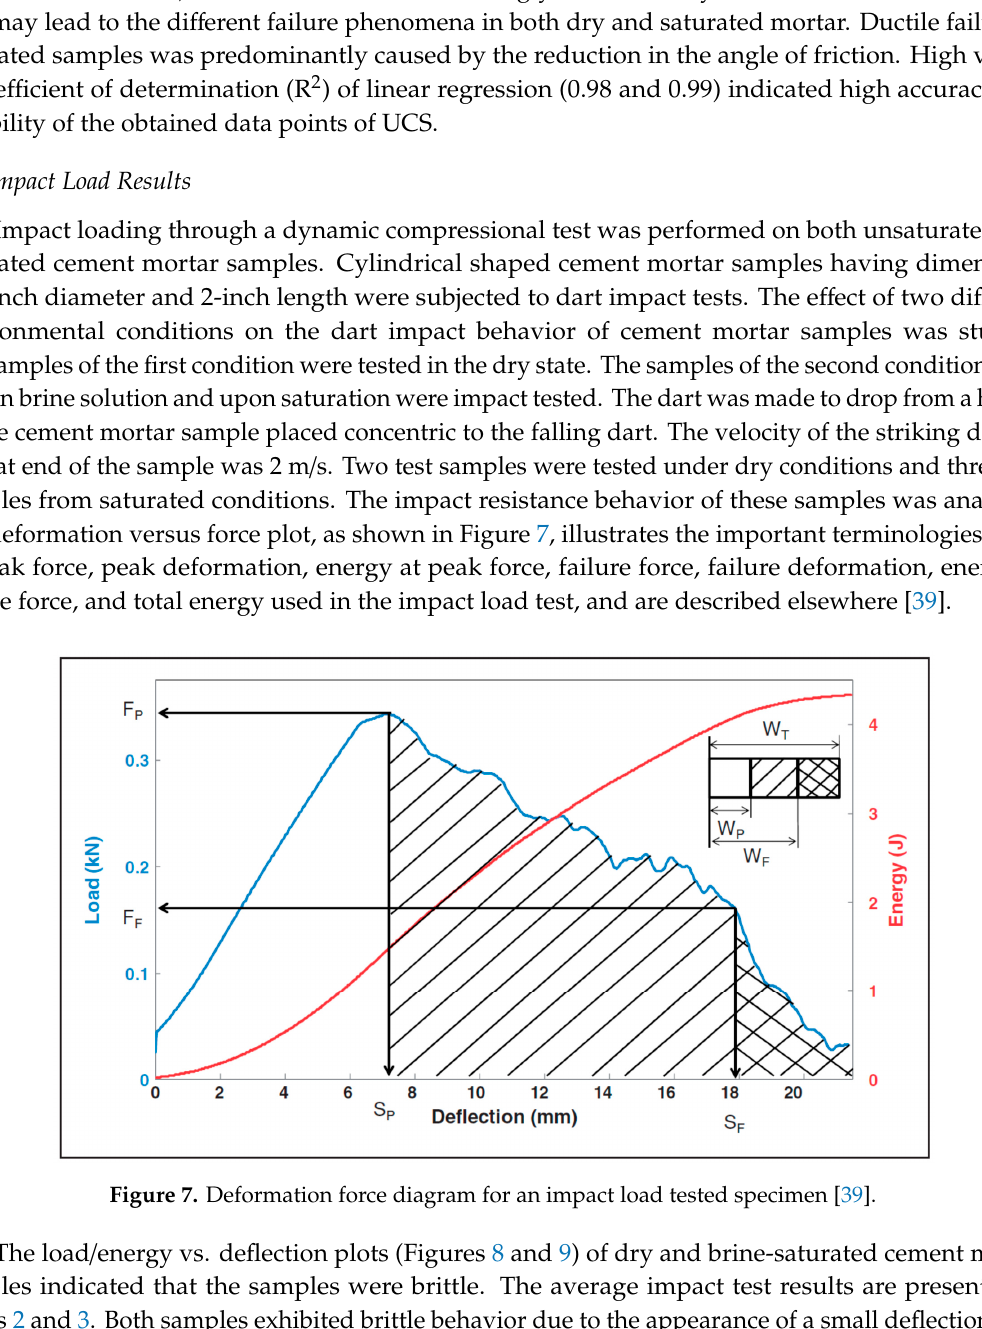
Figure 6. Comparison of uniaxial compressive strength and Young’s modulus for both dry and